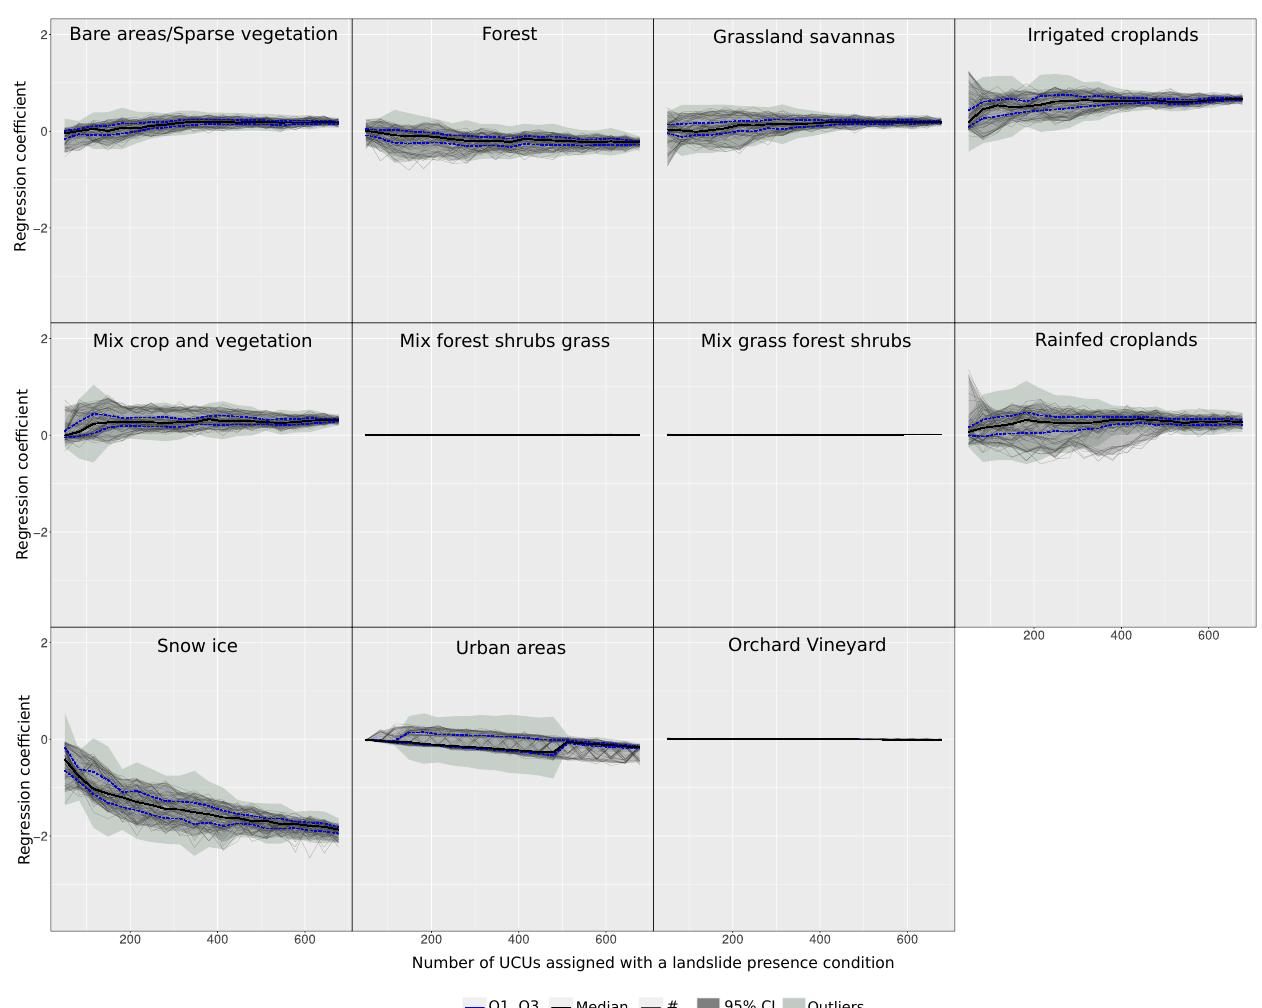
Figure A7. Land use effect graphical summary at a varying proportion of landslide presence